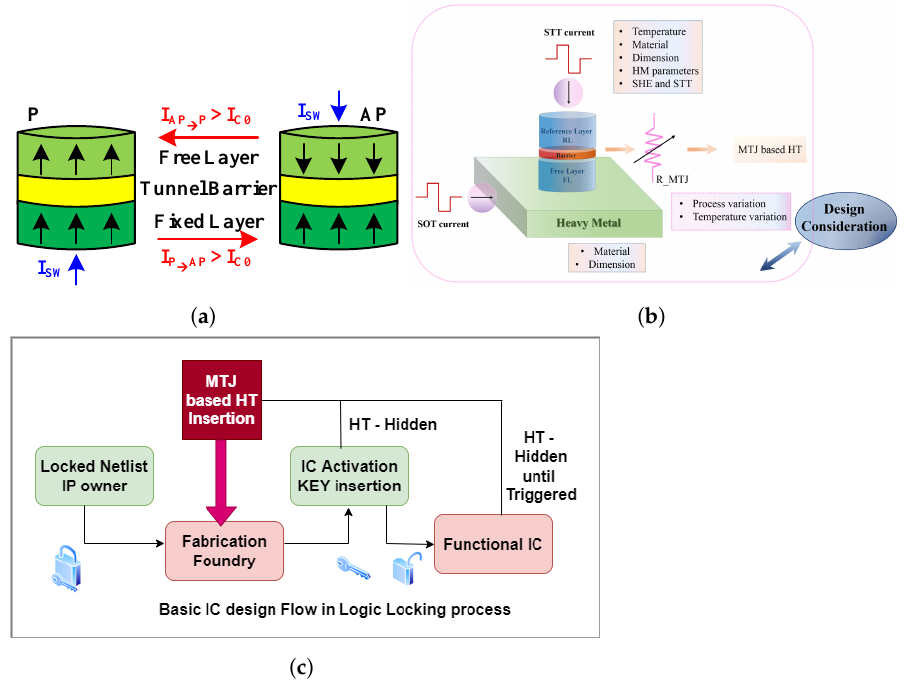
Figure 2. ( a ) A p-MTJ structure and switching between the two states. ( b ) Design consideration for SOT-MTJ. ( c ) Basic IC design flow in logic-locking